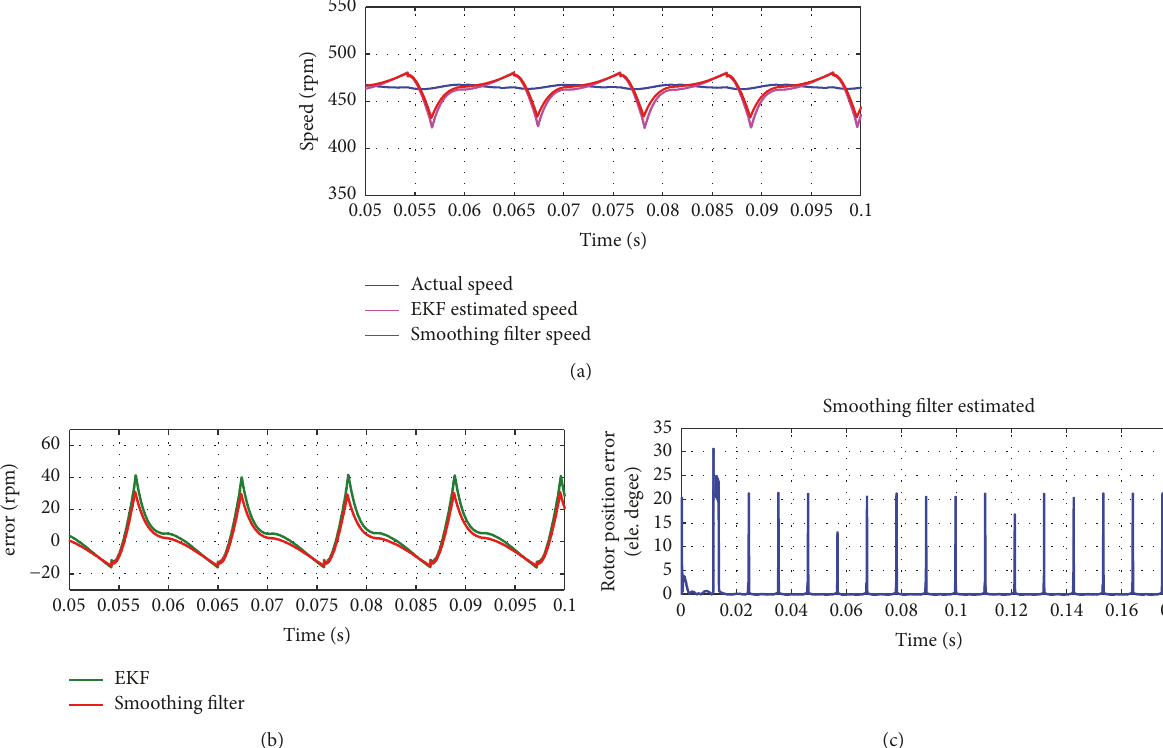
Figure 9: (a) Speed estimation at no load, low speed condition. (b) Speed estimation error. (c) Position estimation error with smoothing